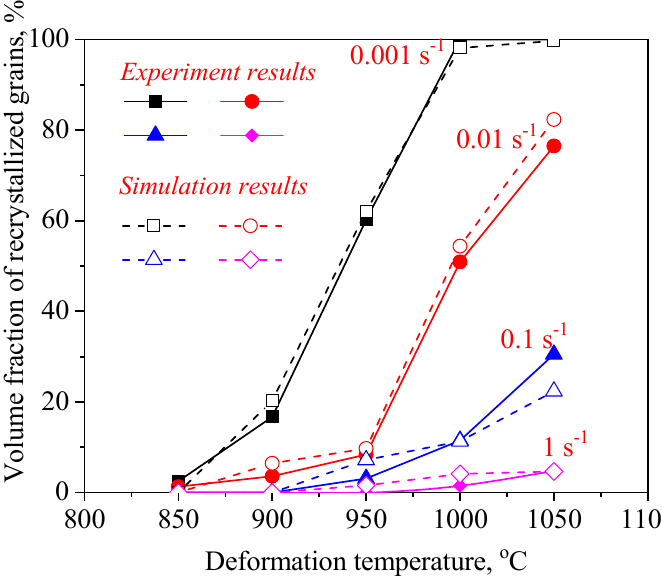
Figure 16. A comparison between the experimental and CA results of the d DRX .